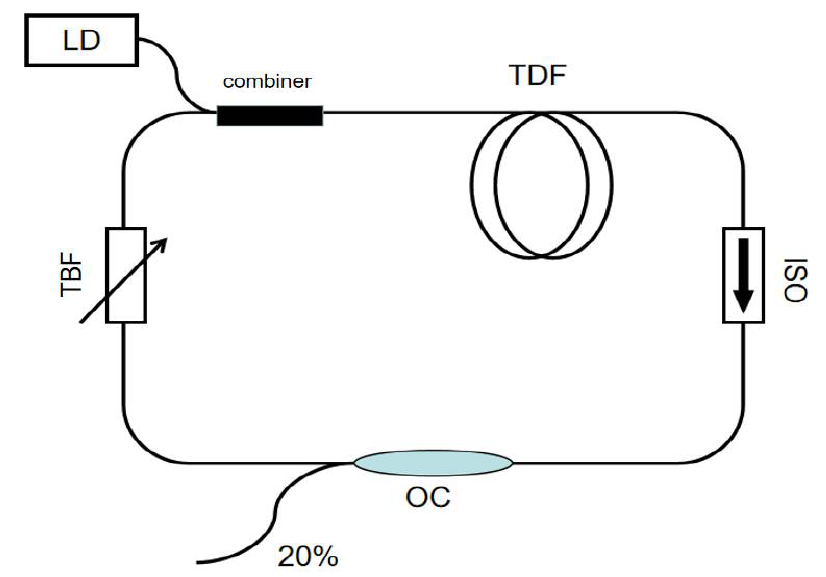
Figure 1. Layout of the all-fiber single-mode wavelength-tunable narrow-linewidth polarization- maintaining (PM) Tm-doped fiber master oscillator. LD: laser diode; TDF: Tm-doped fiber. ISO: isolator; OC: optical coupler; TBF: tunable band-pass filter.